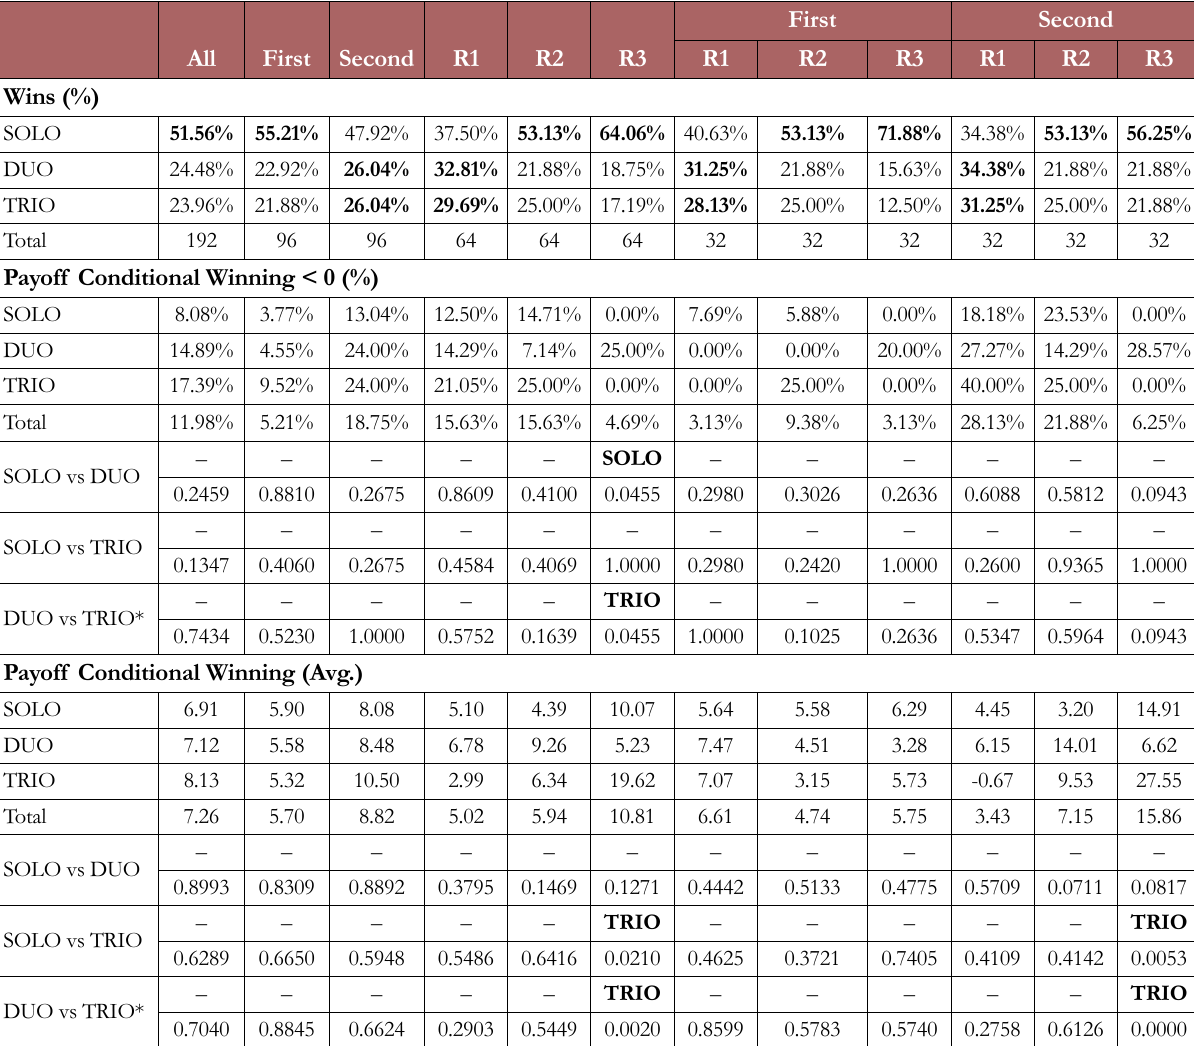
Table A2.2. Experimental game and payoffs conditional on winning: pairwise differences in terms of size by right and